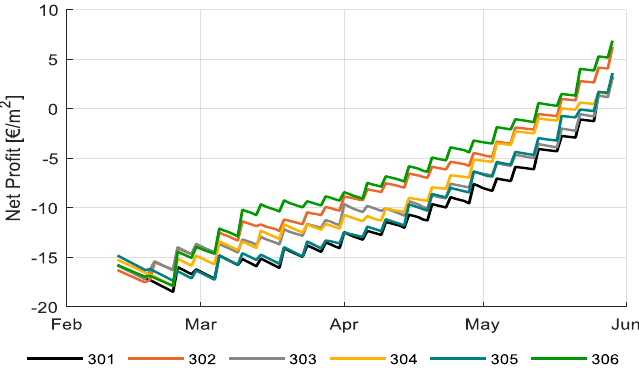
Figure A3. Cumulative income (€/m 2 ) in different greenhouse compartments (301-306) realized by different teams during the harvesting period (13 February until 29 May 2020).